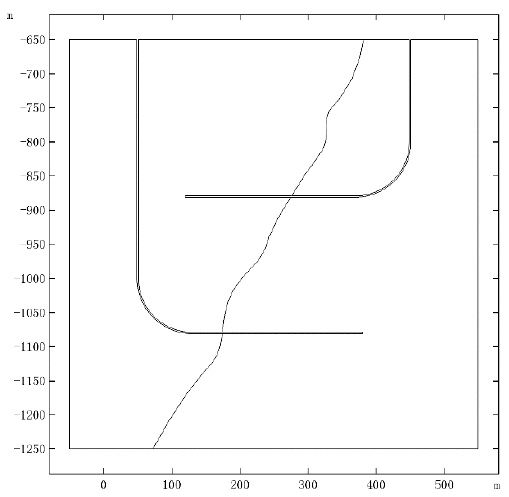
Figure 1. Ideal dual horizontal well EGS exploitation model (unit: m).